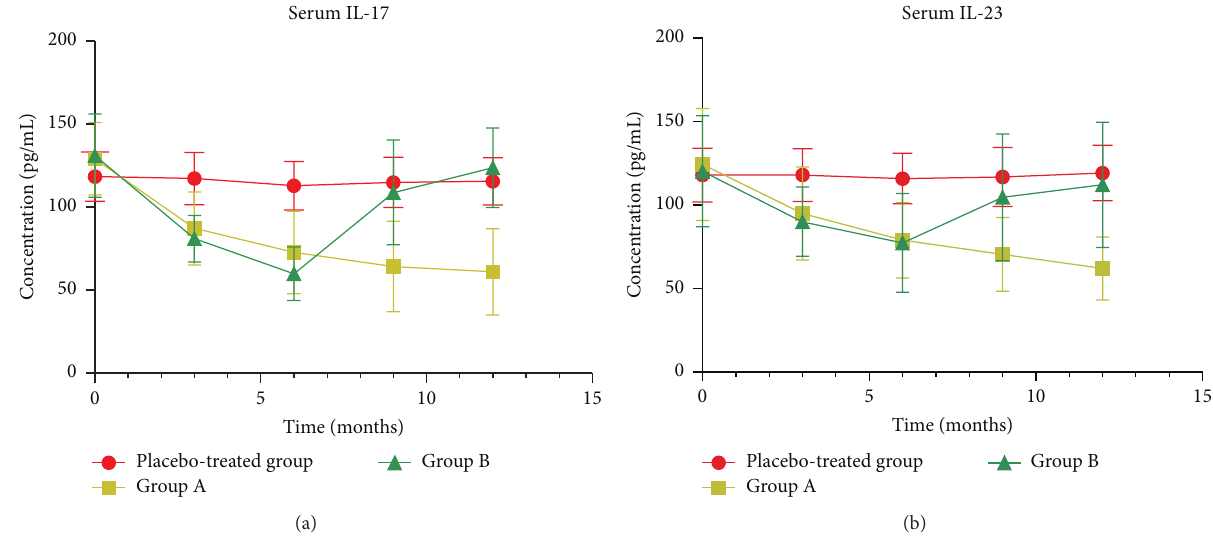
Figure 3: The effects of erythromycin treatment on the concentrations (pg/mL) of IL-17 and IL-23 in chronic obstructive pulmonary disease patients at baseline and after 3, 6, 9, and 12 months of treatment. Erythromycin significantly decreased the levels of IL-17 in serum after 3, 6, 9, and 12 months of treatment in group A (all 𝑃 values < .001) and after 3 and 6 months in group B (all 𝑃 values < .001) compared to the placebo-treated group. A similar change in IL-23 in serum was observed after 3, 6, 9, and 12 months of treatment in group A (all 𝑃 values < .05) and after 3 and 6 months in group B ( 𝑃 = .003 and 𝑃 < .001 , resp.) compared to the placebo-treated group. After 9 and 12 months (after erythromycin was discontinued) in group B, both IL-17 ( 𝑃 > .99 and 𝑃 = .90 , resp.) and IL-23 ( 𝑃 = .67 and 𝑃 > .99 , resp.) in serum showed no differences compared to the placebo-treated group. Table 2: The effect of erythromycin treatment on pulmonary function and 6-minute walk distance. Parameter